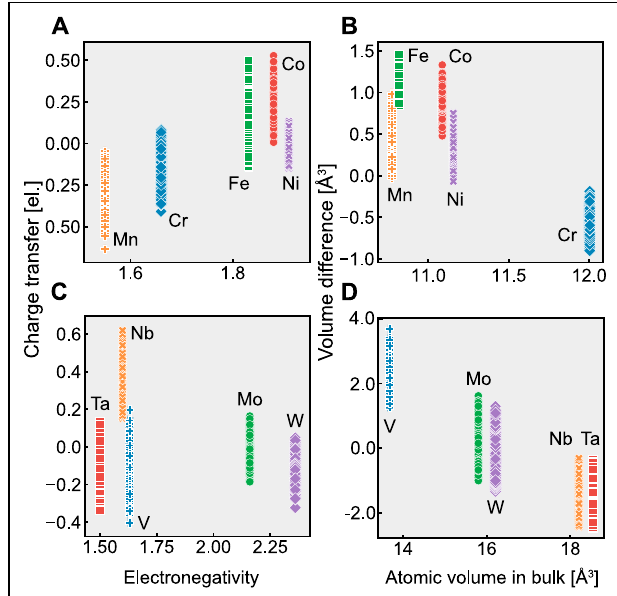
FIGURE 5 | Relationships between charge transfer and electronegativity; and between volume difference and atomic volume in bulk, for (A,B) fcc random alloys and (C,D) bcc random